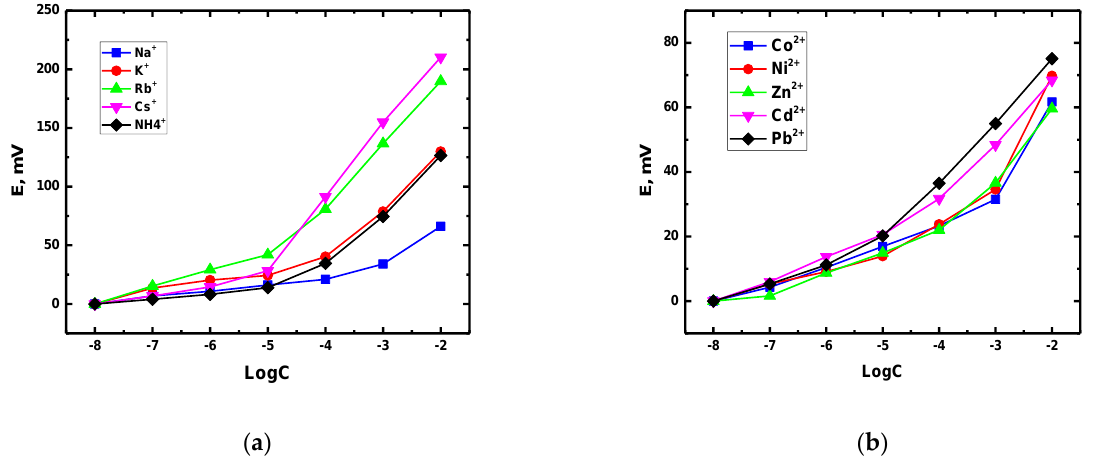
Figure 1. Typical potentiometric response curves: ( a ) L10 sensors for single-charged cations; ( b ) L11 sensors for double-charged cations. The EMF readings are offset to zero for better comparability.